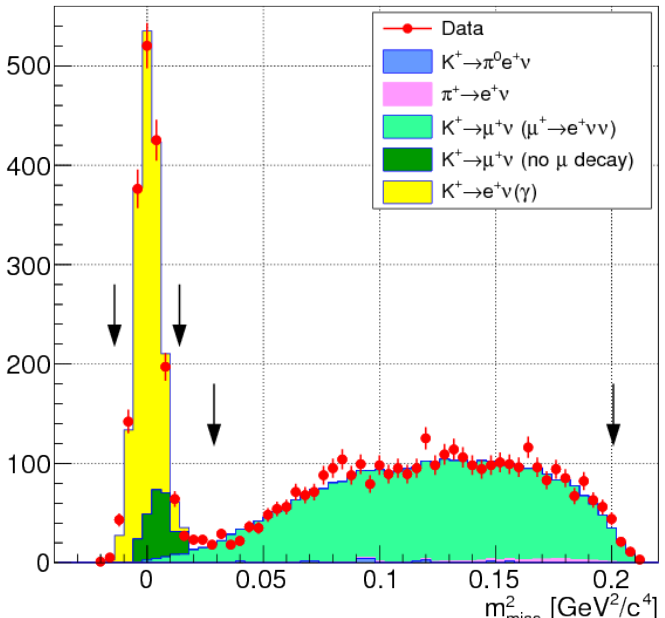
= ( P − P ) 2 , where P K K and P l l miss